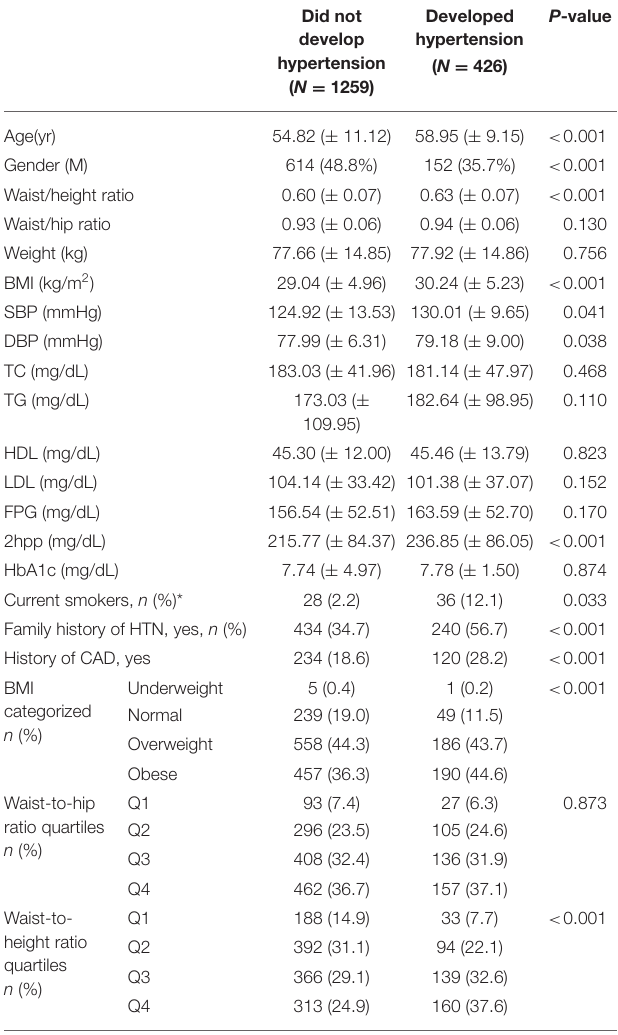
TABLE 1 | Baseline characteristics of the study population, based on hypertension status at the time of follow-up.